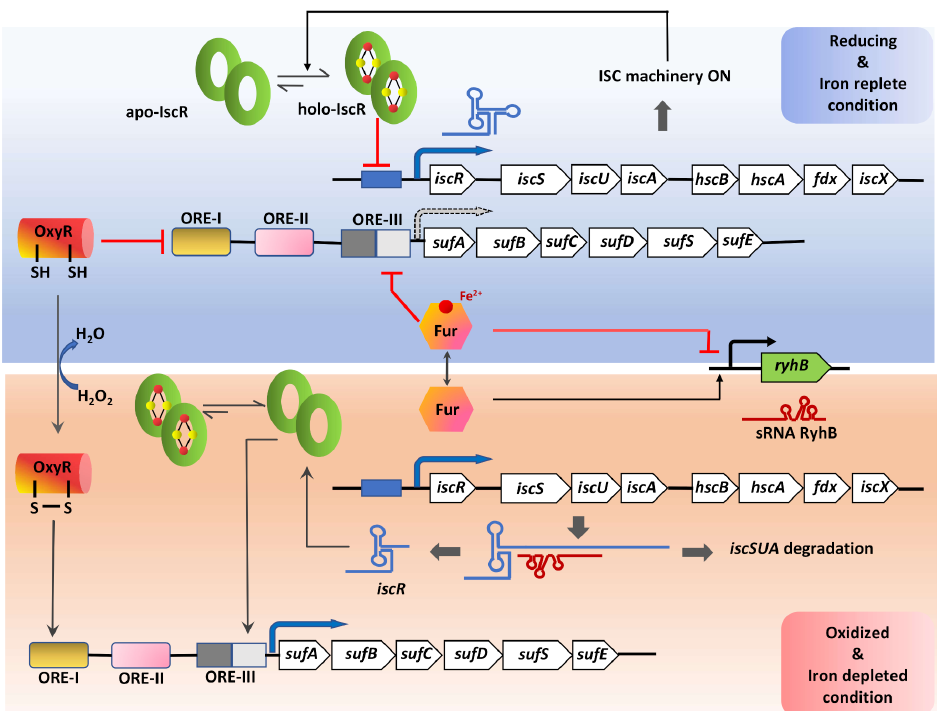
Figure 6. A model for the multistep regulation of Fe-S cluster biogenesis. The expression of the genes involved in Fe-S cluster biogenesis and repair are fine-tuned in accordance with the cellular requirement both under normal growth and stress conditions. This effective regulation is maintained via the role of multiple redox-sensitive transcription factors: IscR, known to regulate both the isc and suf operons with its Fe-S cluster bound (holo-) and unbound (apo-) forms; OxyR, a global regulator that senses H 2 O 2 ; Fur, which senses the availability of iron. Transcript level regulation of the housekeeping ISC machinery is executed by the small non-coding RNA, RhyB, that itself is under the control of the iron-deplete/ replete form of the Fur transcription factor. Under iron-replete conditions, holo-Fur inhibits the transcription of rhyB , but during iron starvation, apo-Fur increases and activates transcription of rhyB that binds to the isc transcript at the iscS Shine-Dalgarno locus leading to its degradation, leaving the iscR transcript intact due to the stability imparted by its secondary structure. This, in turn, increases apo-IscR, which then binds to the ORE-III sequence upstream of the suf operon. Arrow with black dotted border indicates reduced expression of the suf operon under reducing and iron-replete